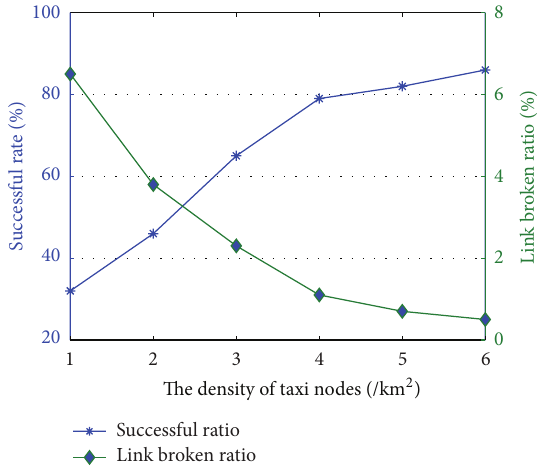
Figure 5: The impact of nodes density on successful ratio.